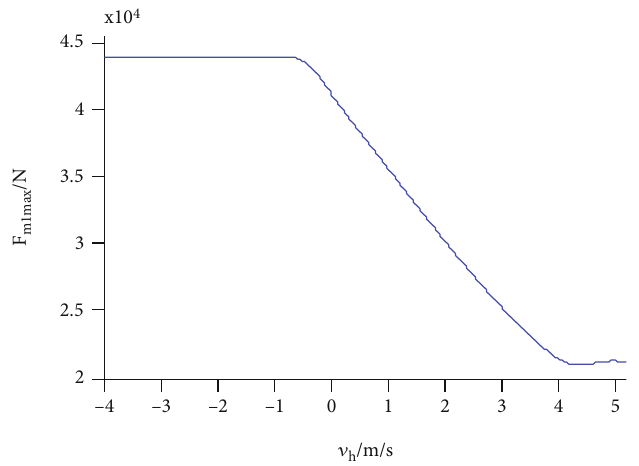
Figure 6: The maximum force on the primary strut 1 vs. the initial horizontal velocity.